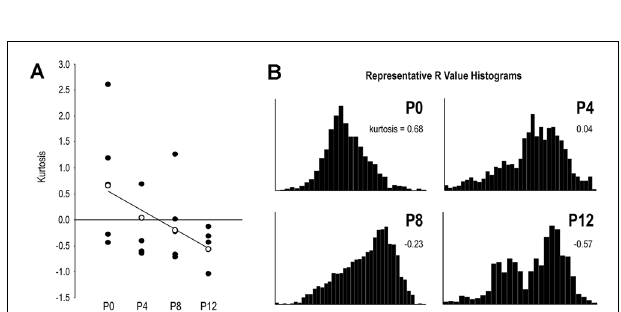
FIGURE 10 | R distribution shape by its kurtosis statistic reveals progressive projection separation during the defined LCIC critical period. Linear regression of kurtosis values by age highlights the developmental trend of increasingly segregated multimodal inputs (A) . Open data markers in (A) closest to the regression line at each age were chosen for plotting representative R value histograms in (B) . Note distinct unimodal character of the P0 distribution as contrasted with the distinct bimodal distribution at P12. P4 and P8 distributions show an emerging and growing tail leading to clear bimodality at